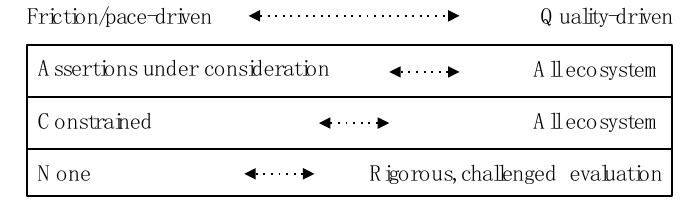
Figure 4. Inference strategy factors.